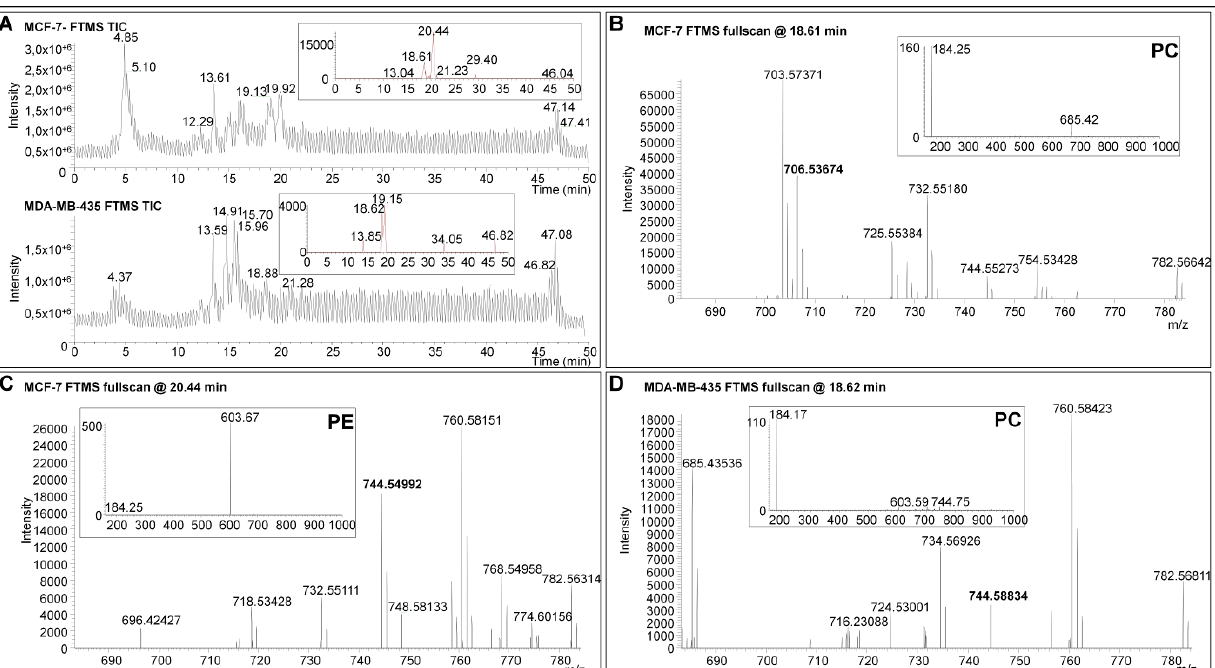
Figure 5. LC-ESI-MS analyses of lipid extracts from MCF-7 and MDA-MB-435 tissues. ( A ) Total ion currents (TIC) of LC-ESI-MS analyses. Insets show the extract ion currents ranging from m/z 744 to 745; and ( B )–( D ): Exact mass measurements acquired with the FTICR analyzer. Insets show MS/MS spectra at respective retention times. The visualization of an ion at m/z 184 indicates that the PL is a PC. Neutral loss fragment of 141 Da indicates that the PL is a